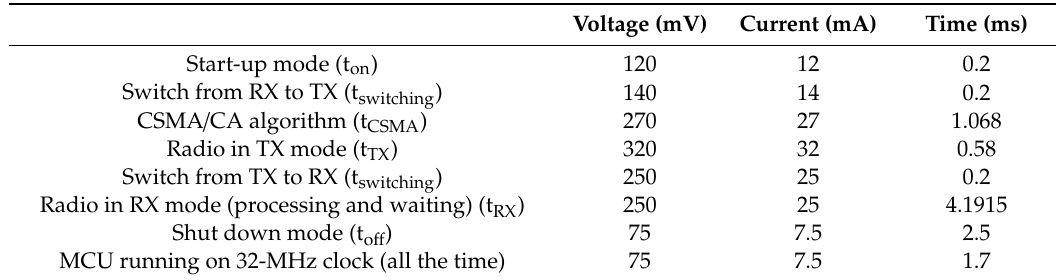
Table 2. Electrical parameters and temporal duration related to the di ff erent operating phases for the Zigbee devices employed in the WSN